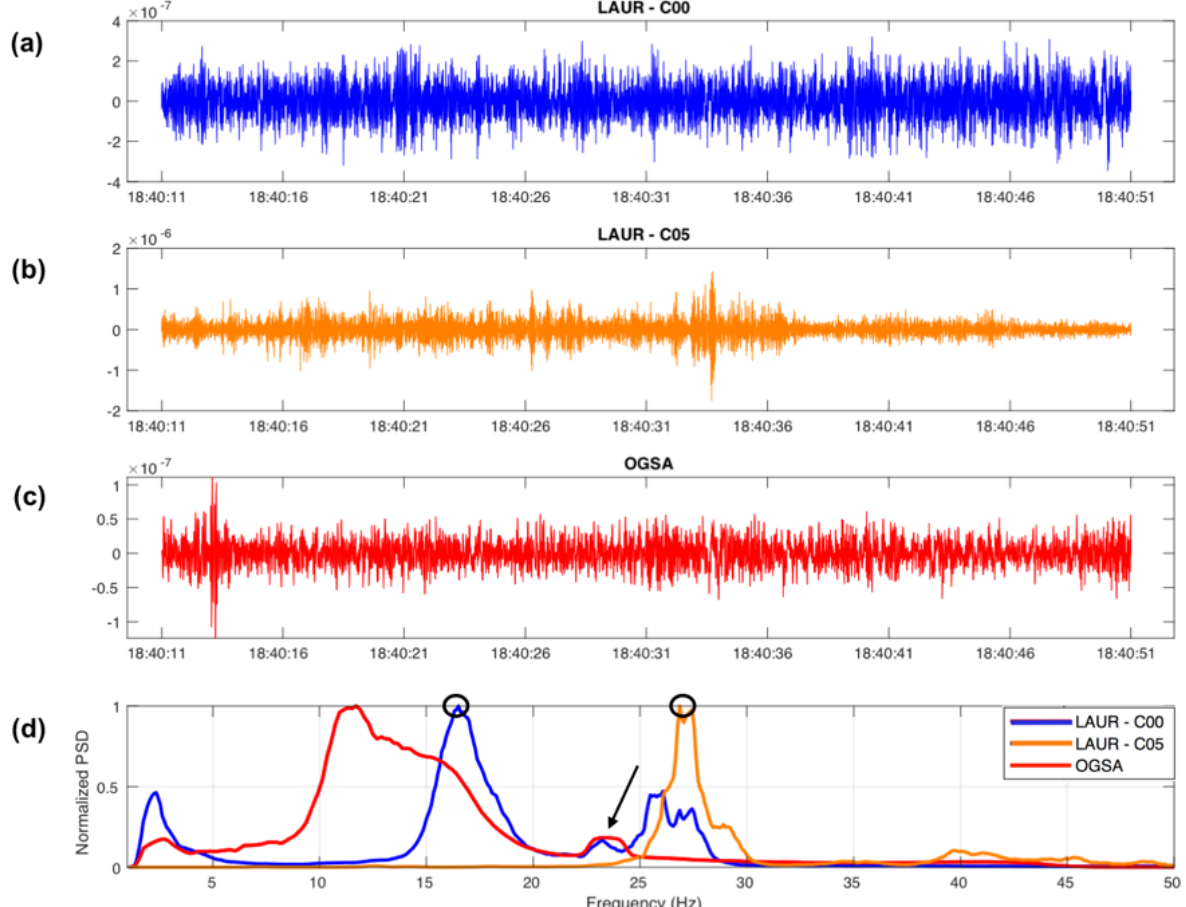
Figure 2. Seismic recordings of ambient noise (vertical ground velocity in m/s, after > 1Hz filtering and instrumental deconvolution) recorded by sensors C00 (a) and C05 (b) on Laurichard rock glacier, and by OGSA station at Col du Lautaret (c) , 5 April 2019 at 18:00UTC. (d) The normalized PSD of the respective signals. Black circles highlight the maxima of these spectrograms that have been picked by using our method (details in the text) for sensors on Laurichard rock glacier. The black arrow shows the stable peak at 23Hz, interpreted as anthropogenic, measured by all sensors (but not clear for C05 sensor due to